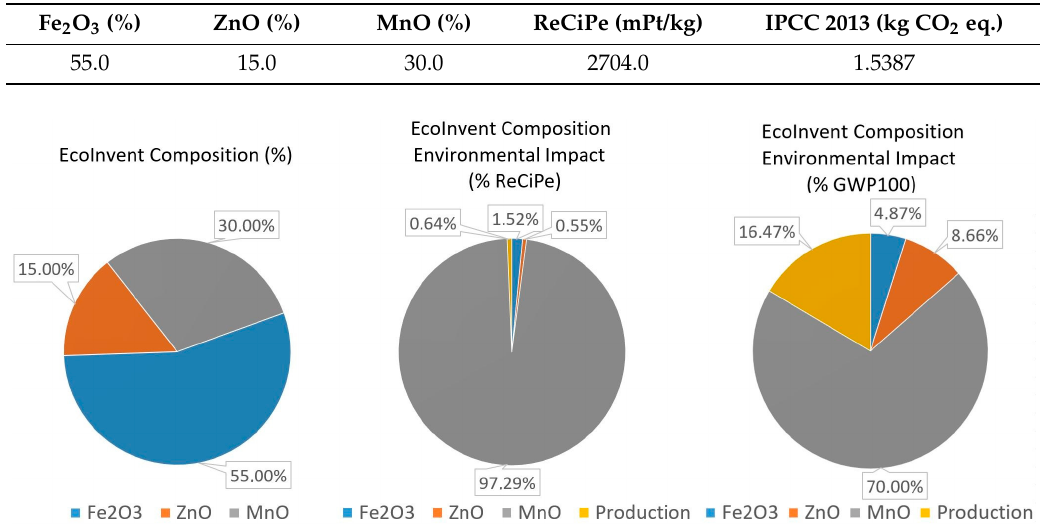
Figure 12. EcoInvent soft ferrite environmental impact in the ReCiPe and Carbon Footprint methodologies.